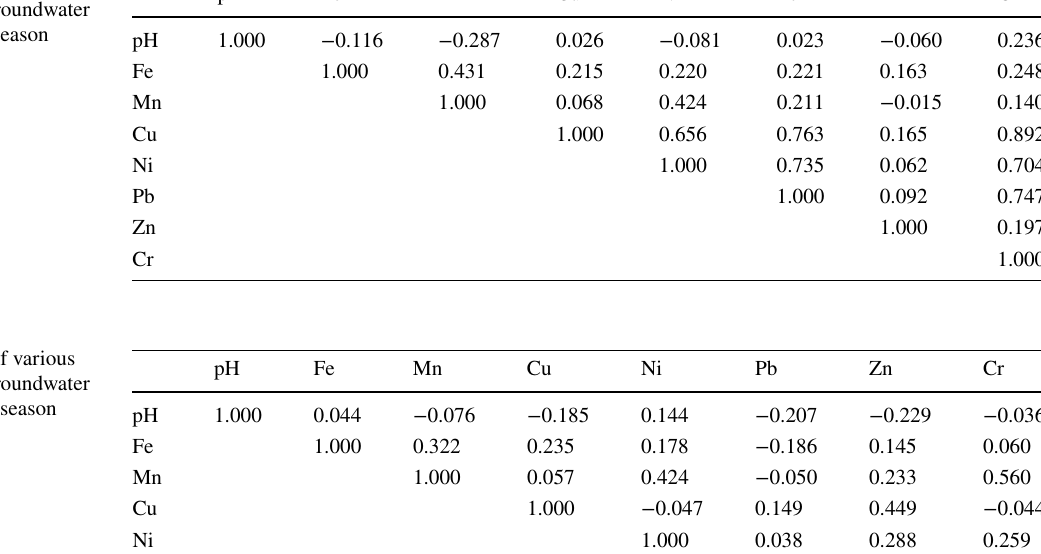
heavy metals in the groundwater during pre-monsoon season